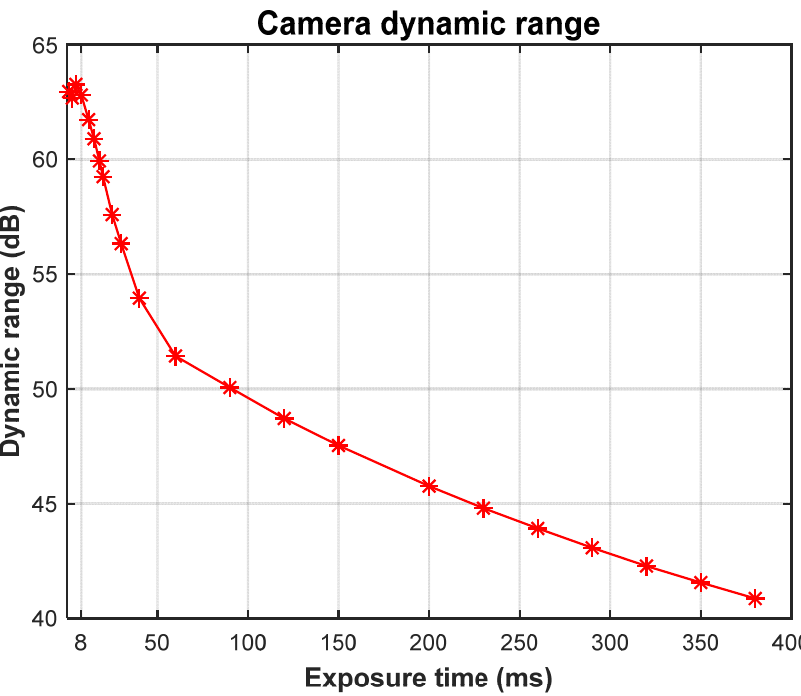
Figure 8. Camera DR vs. exposure time.